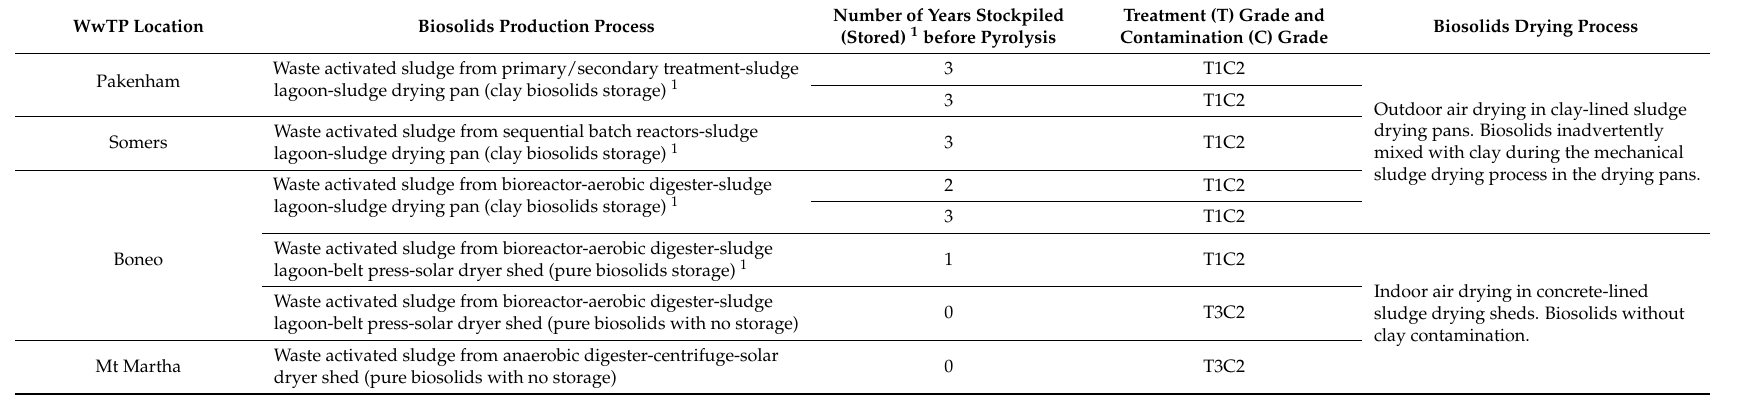
Table 1. Wastewater treatment plant (WwTP) location, biosolids production details, and biosolids